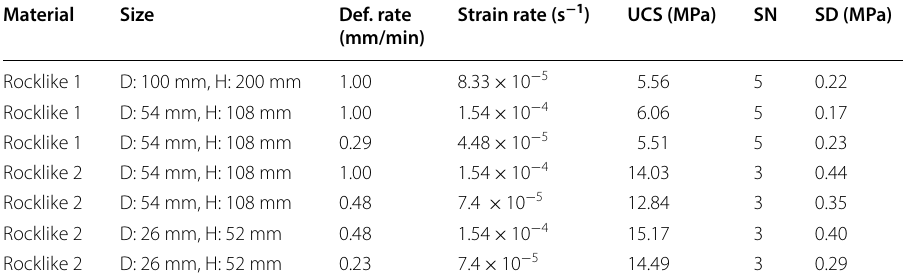
Table 2 Rocklike material strength results obtained from tests with deformation controlled